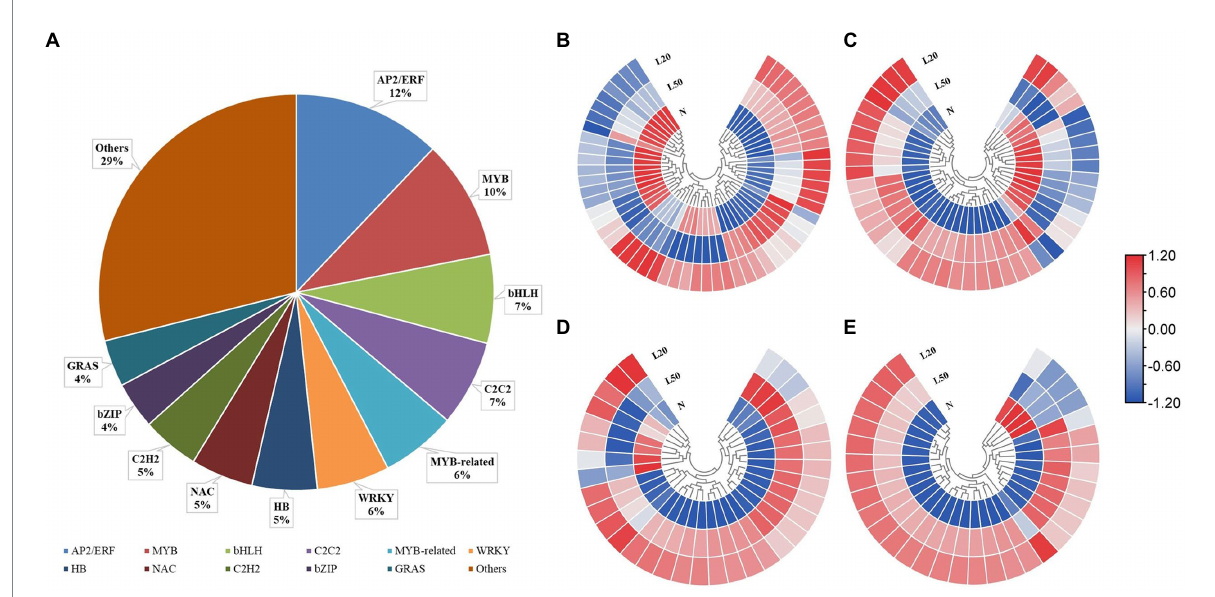
FIGURE 6 Changes in the expression levels of DEGs encoding transcription factors of J. mandshurica under shade. (A) The statistical analysis of transcription factor families in all comparison groups; Heatmap of DEGs involved in (B) AP2/ERF; (C) MYB; (D) bHLH and (E) C2C2 transcription factor family. N: natural sunlight. L50: 50% sunlight to go through. L20: 20% sunlight to go through. The color scale from blue to red indicates the expression value from low to